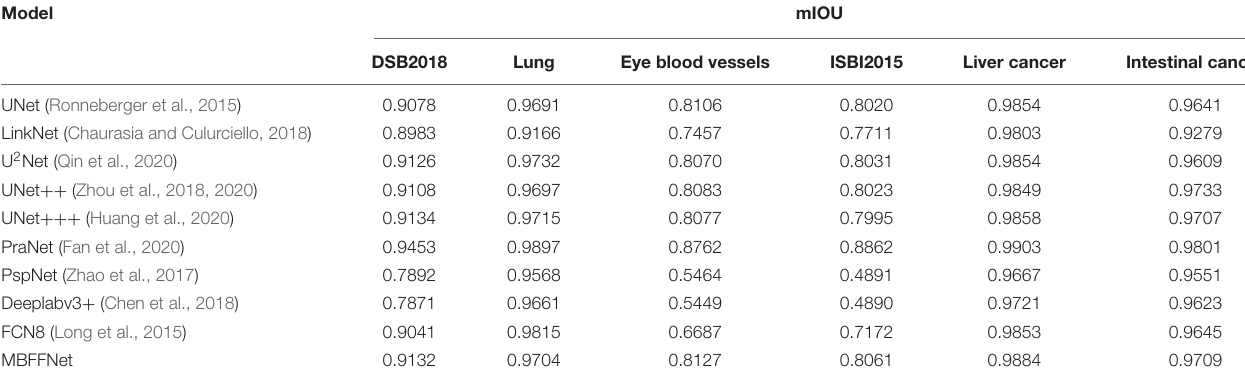
TABLE A1 | mIOU evaluation index of multi-class medical image segmentation.